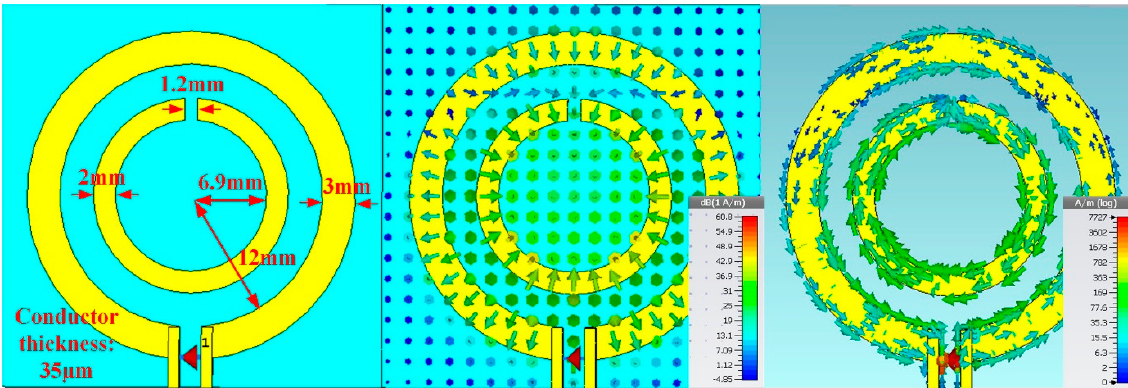
Figure 2. Dimensions and geometry of a resonator-loop antenna couple ( left ). CST simulation results showing h fields ( middle ) and surface current density ( right